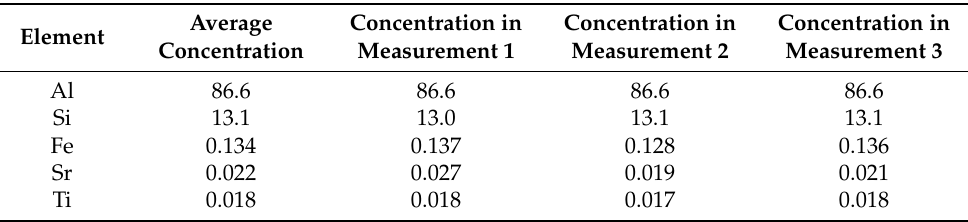
Table 1. Composition of a material jetted AlSi12(a) sample as determined by optical emission spectroscopy. All values in %.